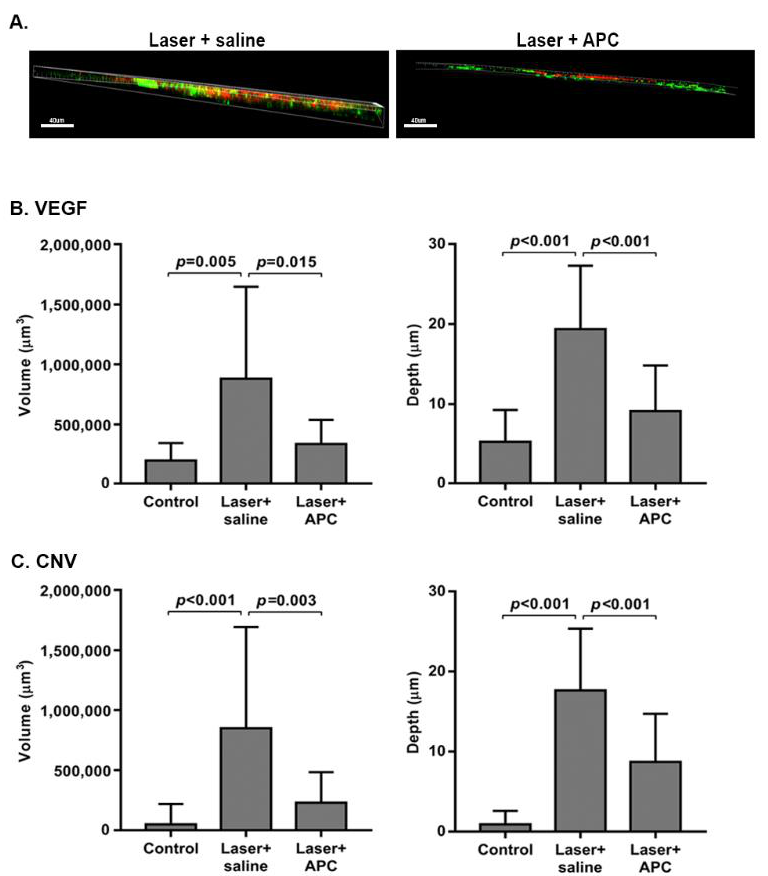
Figure 1. APC treatment induces a reduction in VEGF levels and regression of CNV. Six days post-laser application, CNV was verified by FA, and mice were treated with 1 µ g/ µ L/mouse APC or saline. Mice without laser application that were injected with saline served as a control. Three days later, CNV was stained using FITC-dextran perfusion, and flat RPE-choroid specimens were isolated and stained with anti-VEGF antibodies. Panel ( A ) shows a Z-plane immunofluorescent image of RPE-choroid flatmounts taken from eyes subjected to laser and treated with APC or saline (scale bar represents 40 µ m; red, VEGF; green, CNV). Quantifications of VEGF and CNV volume ( µ m 3 ) and depth ( µ m) were measured using Imaris and are depicted in panels ( B , C ), respectively. The data are presented as mean ± SD (7–9 mice per group) and were analyzed using one-way ANOVA followed by Tukey post hoc test.